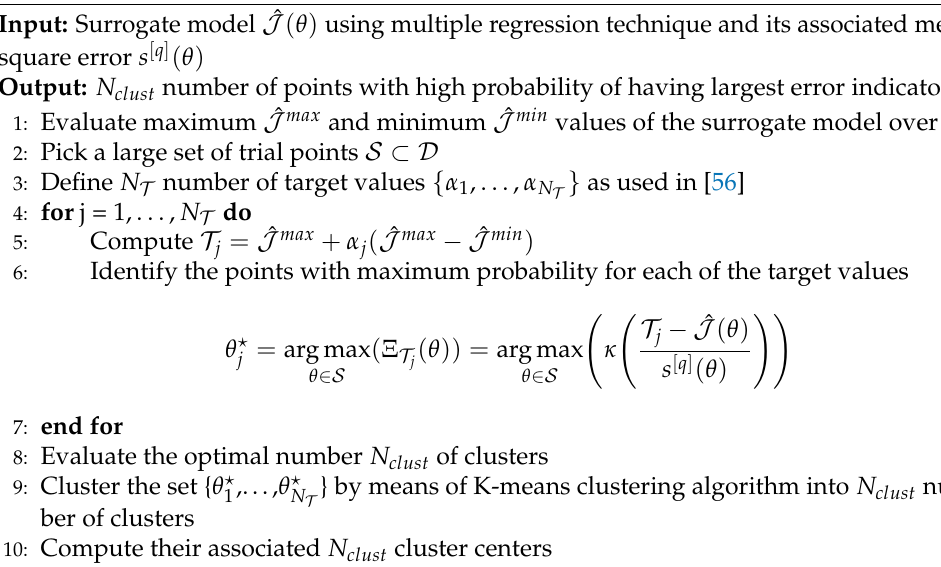
Algorithm 1 Identification of the additional points with maximum probability of having the highest error indicator